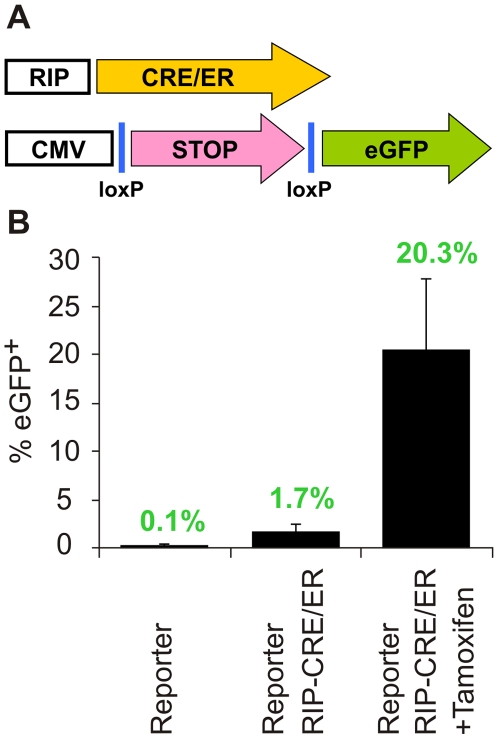
Inducible labeling of human islet cells.A, Schematic representation of the two lentivirus vectors. B, Labeling efficiency and leakiness. Adult human islet cells from 5 donors were infected one day after plating with the reporter virus alone, or with both viruses, and cultured overnight in the absence or presence of tamoxifen. Five days later 104 cells from each donor were analyzed by flow cytometry for eGFP expression. Data are mean±SD (n = 5).